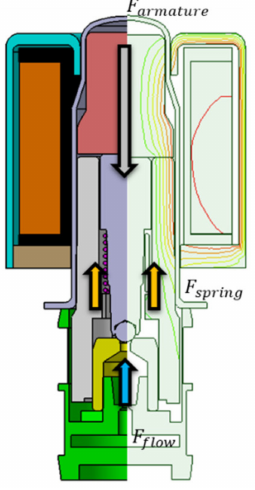
Figure 5. Load distribution of